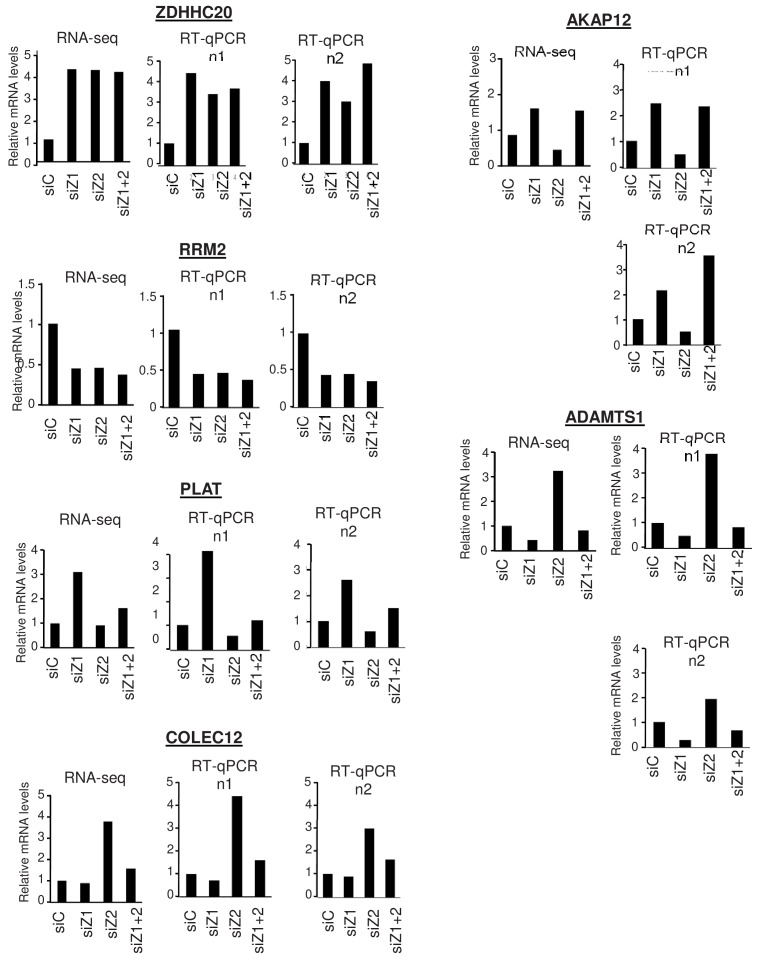
Validation of RNA Seq results.WI38 cells were transfected with the indicated siRNAs. 72 hr later, total RNA was prepared and further purified to be subjected to RNA-Seq or analysed by RT-qPCR. RNA-Seq signals were averaged for the indicated genes and calculated relative to one for the control siRNA sample. RT-qPCR data for the indicated genes was standardised using GAPDH mRNA levels and calculated relative to one for cells transfected with the control siRNA. The data for the two samples sent to RNA-Seq are shown.Figure 2—figure supplement 1—source data 1.Source data of the histogrammes representing the validation of RNA-seq effects by RT-qPCR on Figure 2—figure supplement 1.